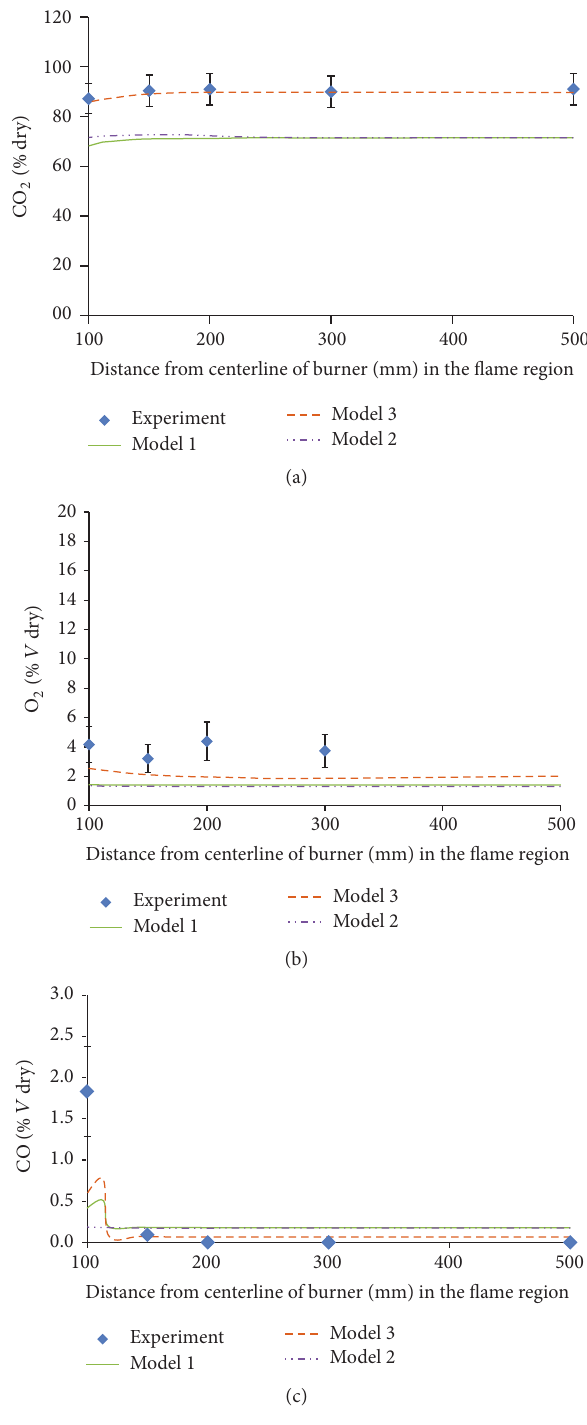
Figure 11: (a) Predicted and measured CO 2 volume percentage (dry basis) on the half radial axis at 𝑥 = 359 . (b) O 2 volume percentage (dry basis) at the half radial axis at 𝑥 = 359 . (c) CO volume percentage (dry basis) at the half radial axis at 𝑥 = 359